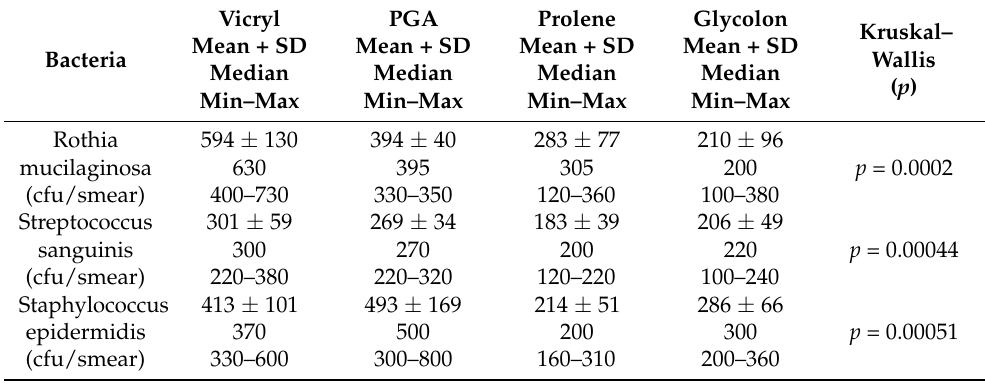
Table 4. The number of bacteria absorbed on the surface of the threads on the 7th day.